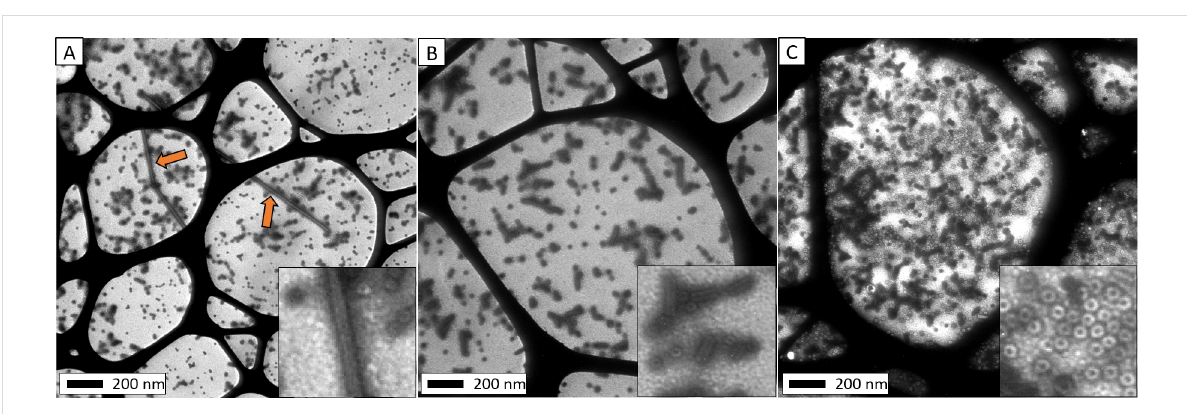
Figure 5: TEM images of TMV-cp assembled at pH 5.5 in the presence of different alcohol additives. (A) 5.0 mol % methanol; (B) 10.0 mol % metha- nol; (C) 3.5 mol % isopropyl alcohol. Orange arrows indicate long rod